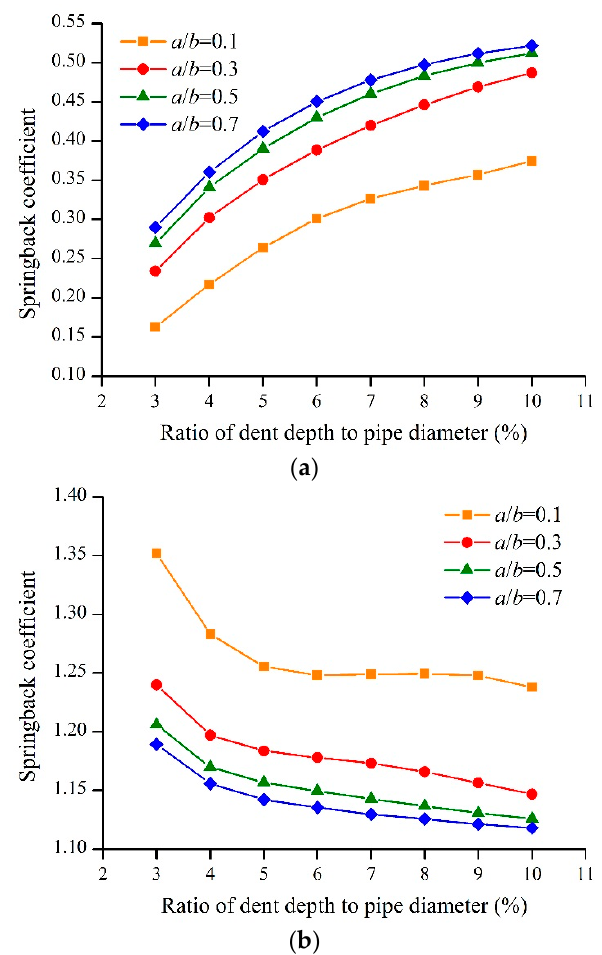
Figure 8. Dent depth and springback coefficient with variation of the indenter sizes during denting: ( a ) pressurization; ( b ) de-pressurization.